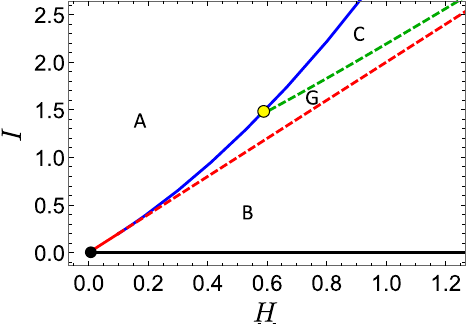
FIG. 3. Bifurcation diagram Σ for the integrable Hamiltonian system of IOTA (9) – (11) at the nominal operating value τ ¼ − 0 . 4 , separating the ð H; I Þ plane into four regions with distinct dynamical behavior. Curves in blue, green, red, and black correspond to the four curves in (17), respectively. Significance of the solid-dashed distinction and the large dots is explained in Sec. IV C.